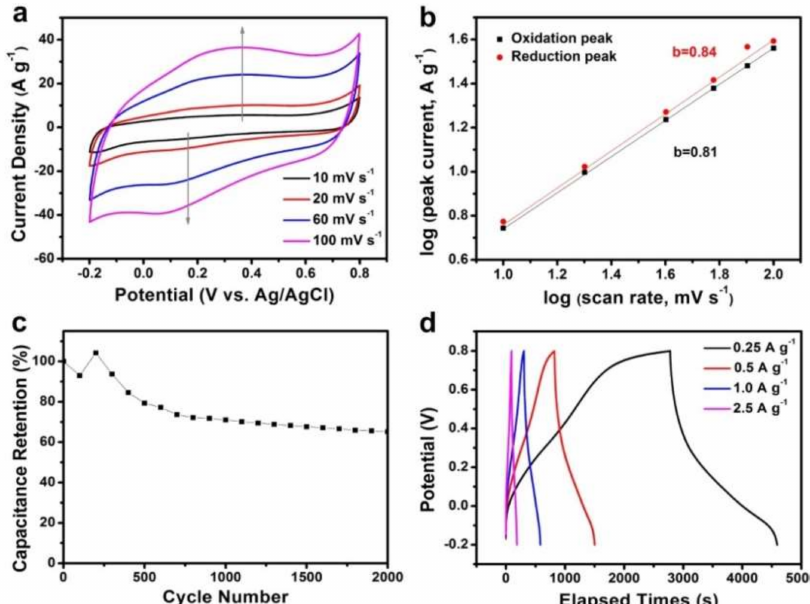
Figure 5. ( a ) Cyclic voltammograms (CVs) of OMPW, ( b ) plots of log (current) versus log (scan rate), ( c ) cycling performance of OMPW at a scan rate of 100 mV s − 1 , and ( d ) galvanostatic charge/discharge curves of OMPW at different current